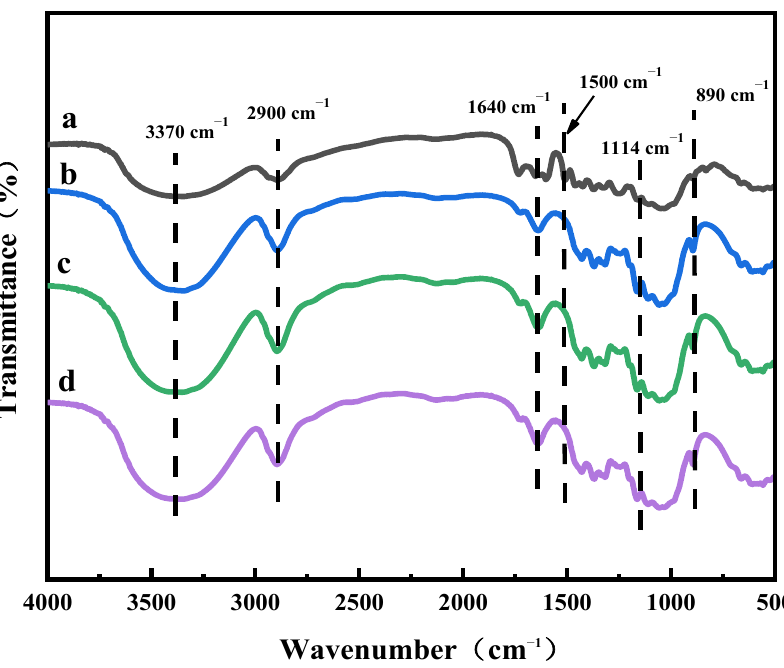
Figure 3. Infrared spectrum: ( a ) Neosinocalamus affinis powder; ( b ) 250 μ m cellulose; ( c ) 178 μ m cellulose; ( d ) 150 μ m cellulose. Table 2. Characteristic peaks of some groups in the infrared spectrum.